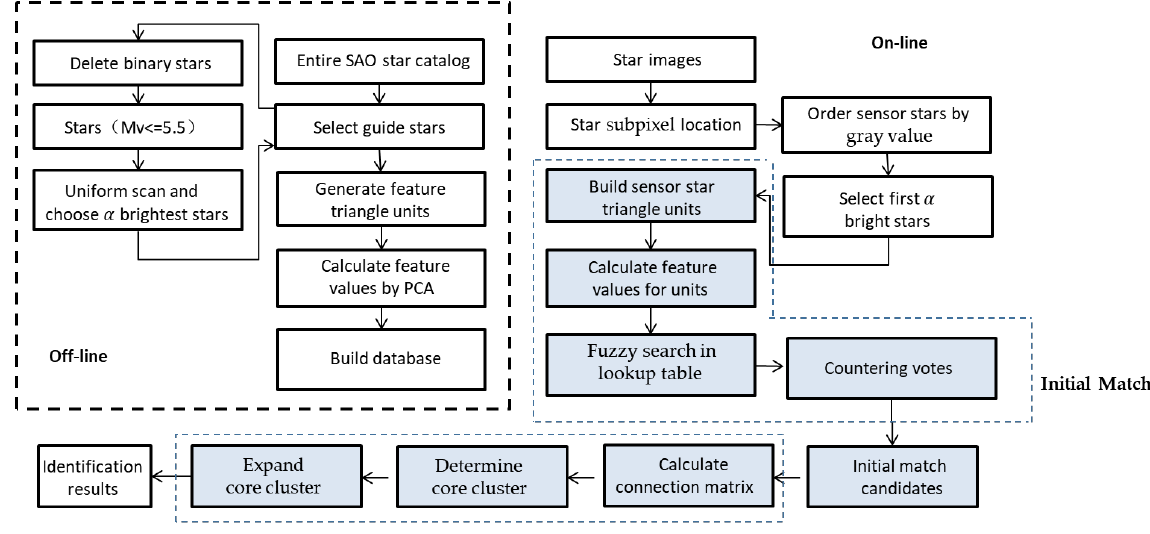
Figure 4. The process of the algorithm.